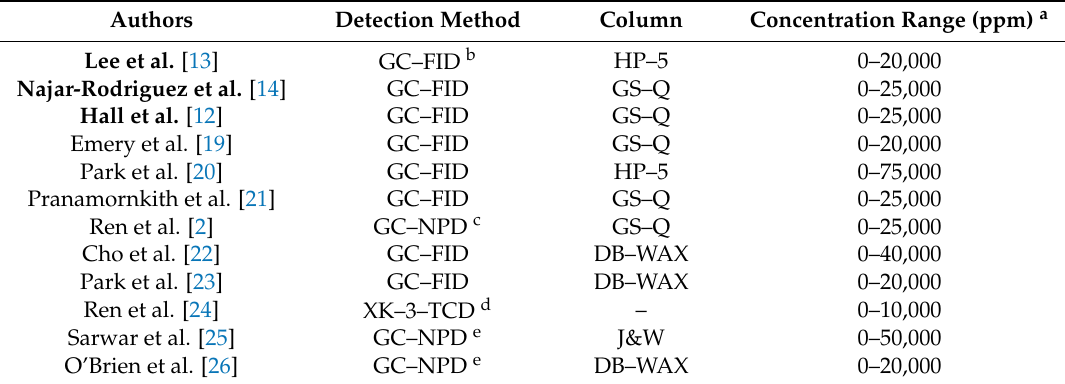
Table 1. List of recent studies (most recent to oldest) which quantify ethanedinitrile in air and their respective detection methods, columns and concentration